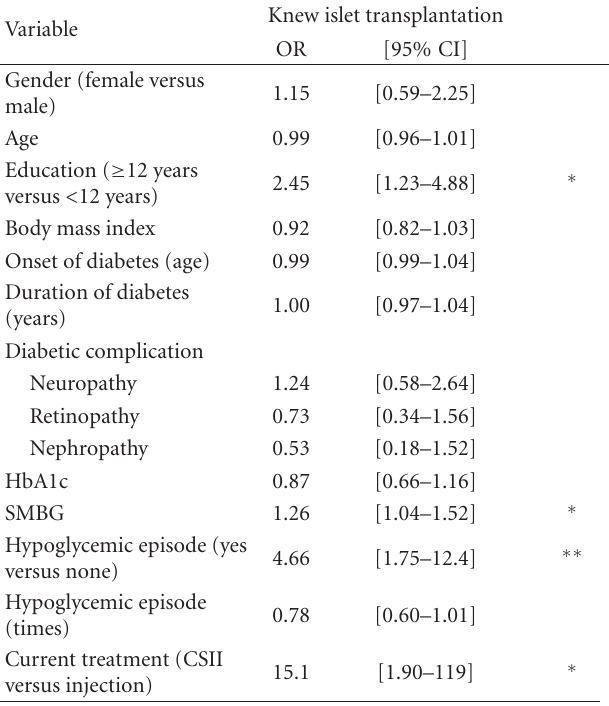
Table 4: Factors related to knowledge about pancreatic islet trans- plantation ( N = 137; logistic simple linear regression